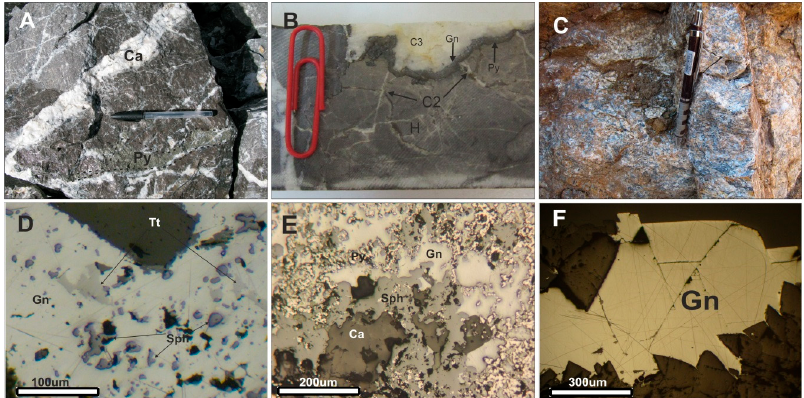
Figure 2. ( A ) Pyrite-bearing veins on the ore body; ( B ) rhythmic deposition of calcite, pyrite, galena and late stage calcite; ( C ) barite (Ba) and galena (Gn) on the photo; ( D ) photomicrograph showing sphalerite and tetrahedrite hosted by galena; ( E ) sphalerite intergrowth with galena engulfed pyrite; and ( F ) late-stage open space filling galena whiteout sulfide mineral inclusion. H: Host rock; Ca: Calcite; C2: stage II calcite; C3: stage III calcite; Ba: Barite; D: Dolomite; Py: Pyrite; Gn: Galena; Sp: Sphalerite; T: Tetrahedrite. D–F under the Plan Polarized Light (ppl).